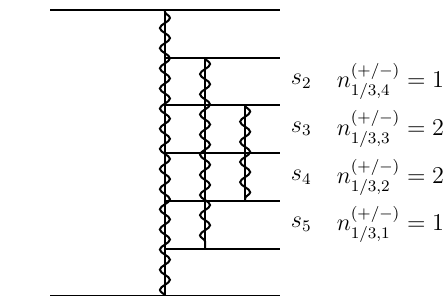
-channel. 4 - and t - 3 4